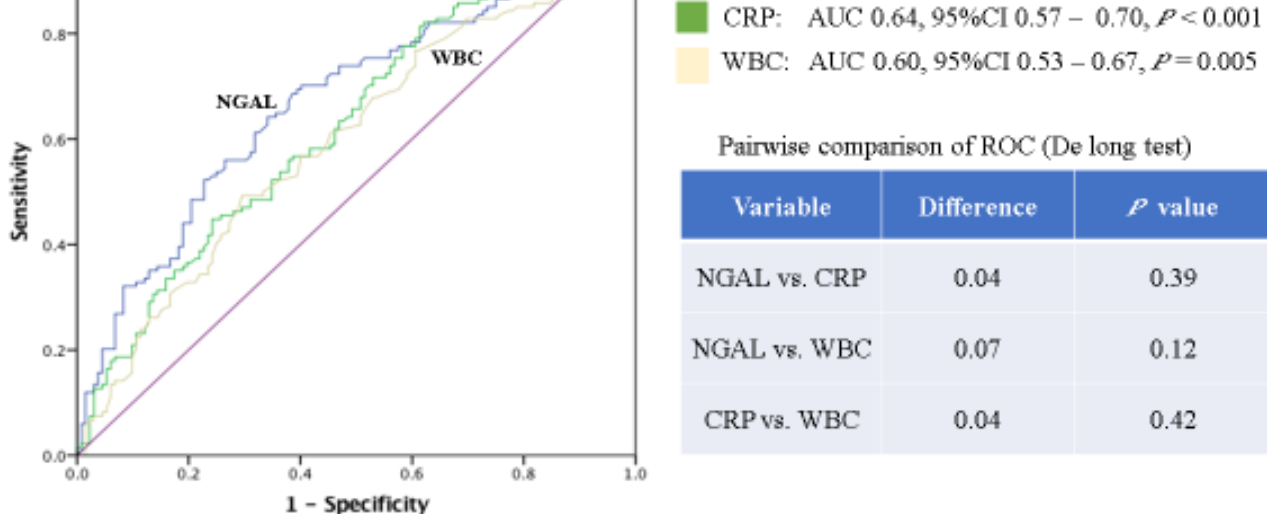
Figure 3. ROC and corresponding AUCs of inflammatory laboratory markers for prediction of the combined endpoint: AKI or MACE; NGAL, neutrophil gelatinase-associated lipocalin; CRP, C-reactive protein; WBC, white blood cells.